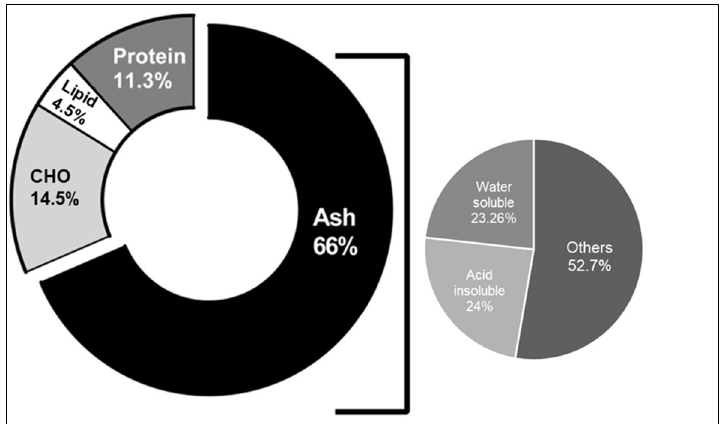
Figure 1. Pie chart showing the organic (proteins, lipids, and carbohydrates) and ash (water-soluble and acid-insoluble) content of the Lebanese red seaweed, J. rubens . Table 1. Proximal analysis of J. rubens .